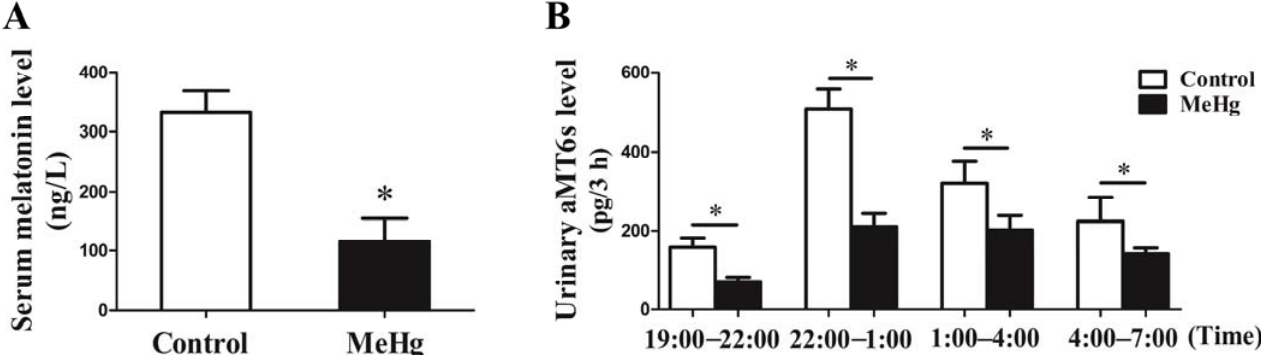
Figure 4. Impact of MeHg exposure on serum melatonin ( A ) and urinary aMT6s ( B ) in rats. MT, melatonin. The data are expressed as mean ± SD for eight rats per group. * p < 0.05, significant difference compared to the control group.